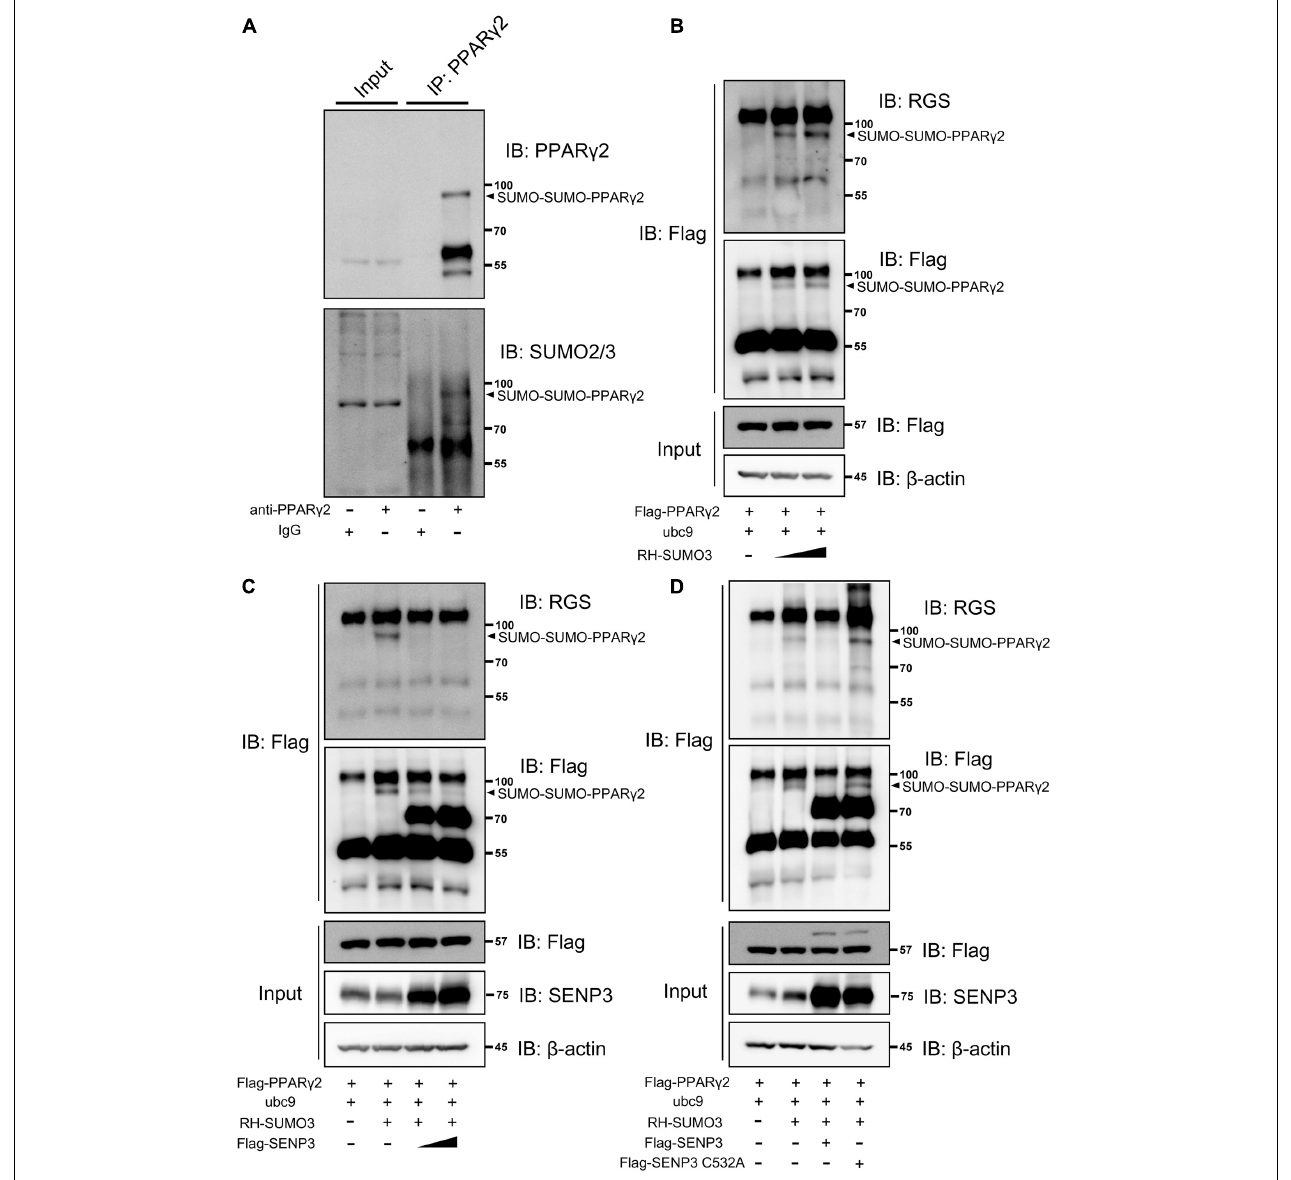
FIGURE 4 | Peroxisome proliferator-activated receptor γ 2 (PPAR γ 2) can be SUMO2/3 modification during adipogenic induction and deSUMOylated by SENP3. (A) The endogenous SUMO2/3 modification of PPAR γ 2 in BM-MSCs during adipogenesis. Whole-cell lysates were prepared from BM-MSCs undergone adipogenic differentiation at day 3 and were incubated with antibody specific to PPAR γ 2. The co-eluted proteins were detected by using PPAR γ 2 and SUMO2/3 antibody. (B) PPAR γ 2 can be modified by SUMO3 when co-expressed in HEK293T cells in dose-dependent manner; Flag-PPAR γ 2, ubc9 and RH-SUMO3 were co-expressed in HEK293T cells and co-IP assays were performed with Flag and RGS antibody; (C) the SUMOylation of PPAR γ 2 can be removed by SENP3; Flag-PPAR γ 2, ubc9, Flag-SENP3, and RH-SUMO3 were co-expressed in HEK293T cells and co-IP assays were performed with Flag and RGS antibody; (D) SENP3 mediated de-SUMOylation depended on its active site cysteine 532 (C532); Flag-PPAR γ 2, ubc9, Flag-SENP3 (WT and C532A mutant) and RH-SUMO3 were co-expressed in HEK293T cells and co-IP assays were performed with Flag and RGS